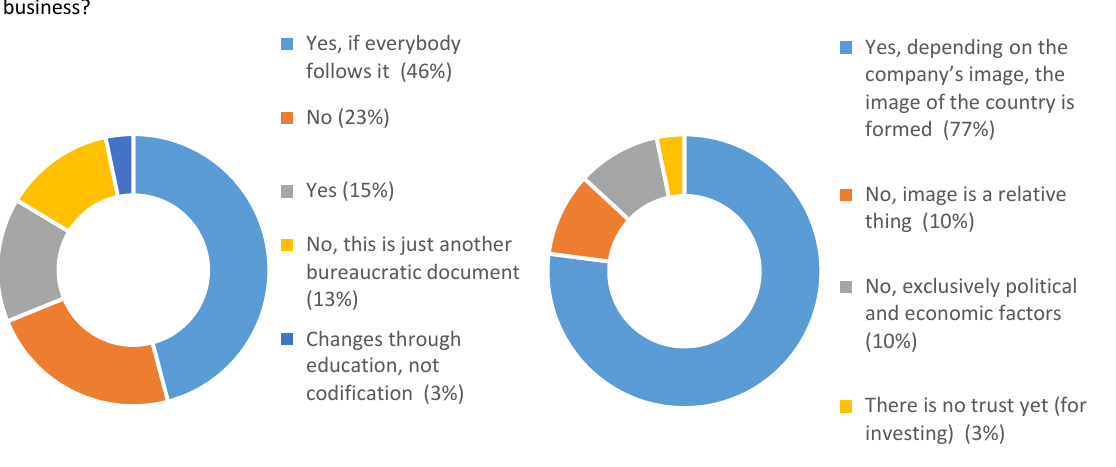
Figure 4. Structural indicators of answers to questions that determine the possibility of using the results, applying qualitative research